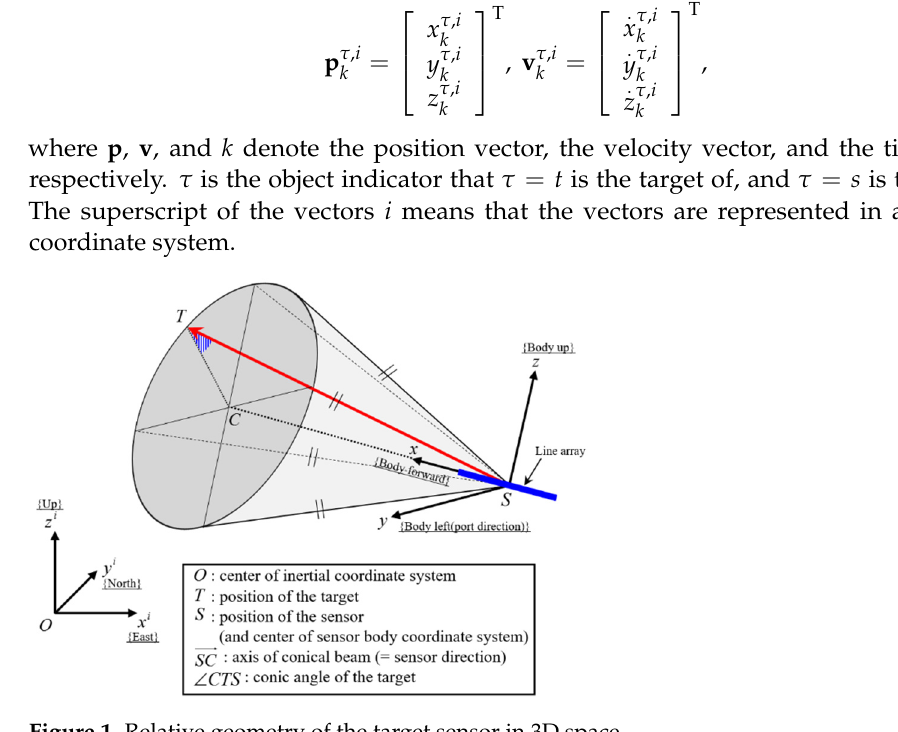
Figure 1. Relative geometry of the target sensor in 3D space.